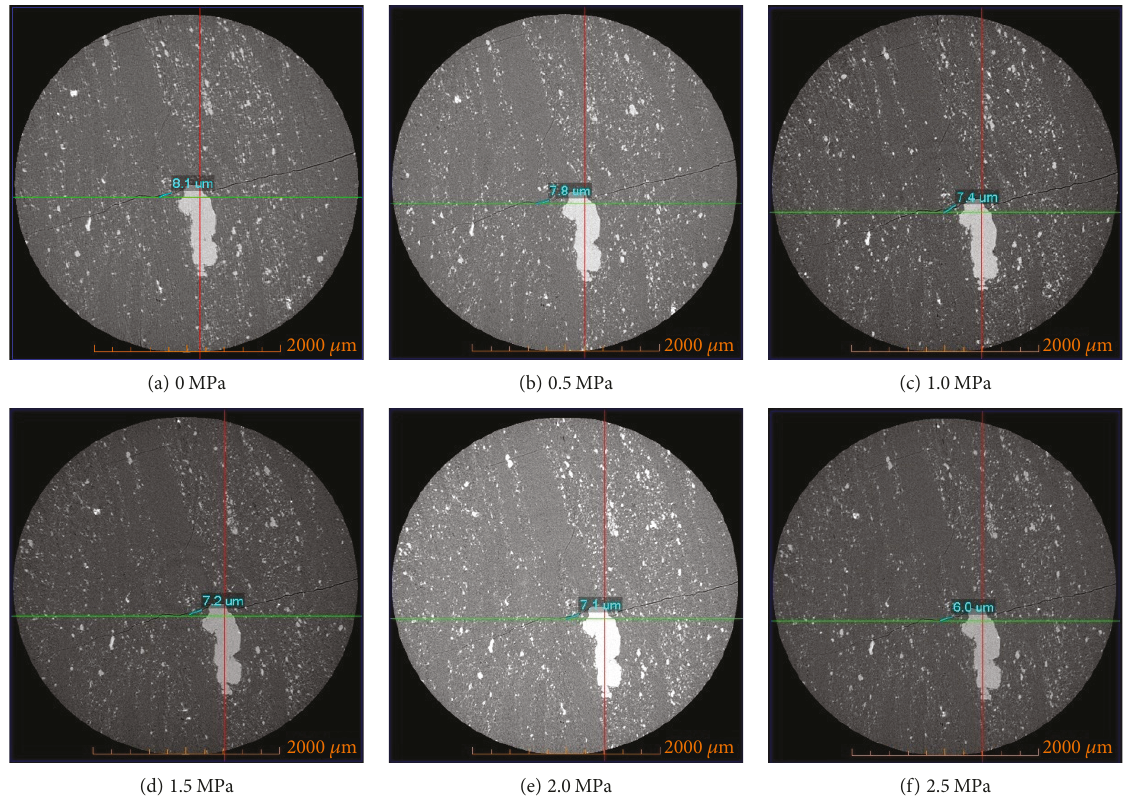
Figure 8: CT images of fracture size (xy